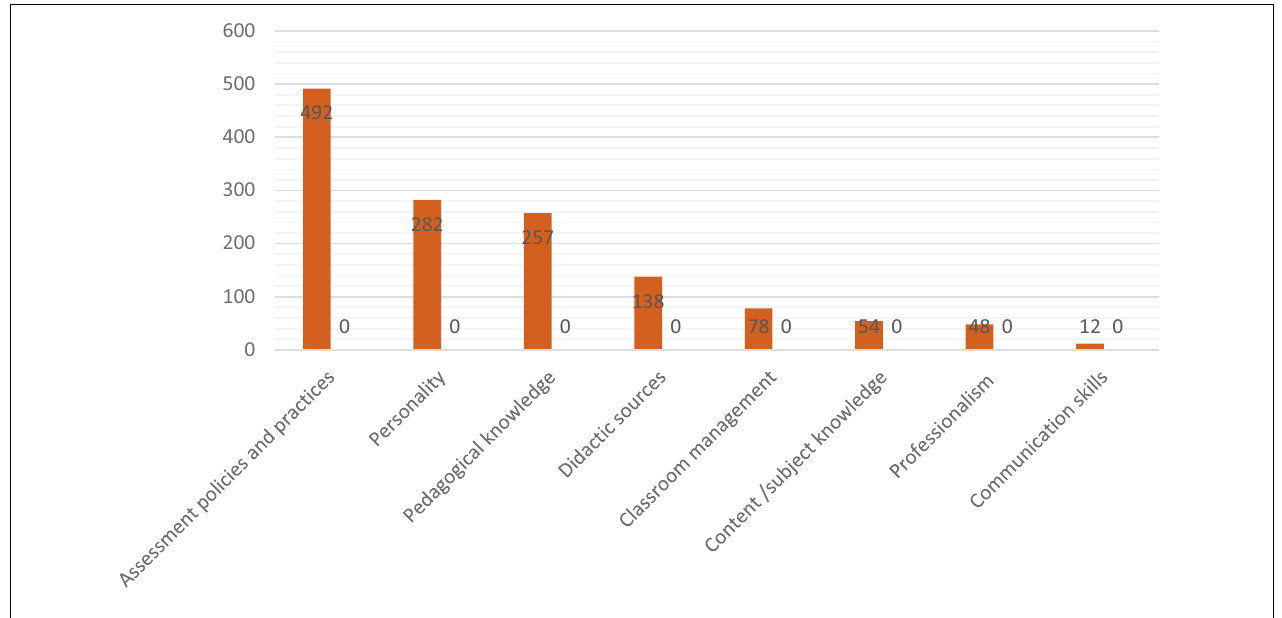
FIGURE 1 | The breakdown of an effective university professor characteristics as perceived by the